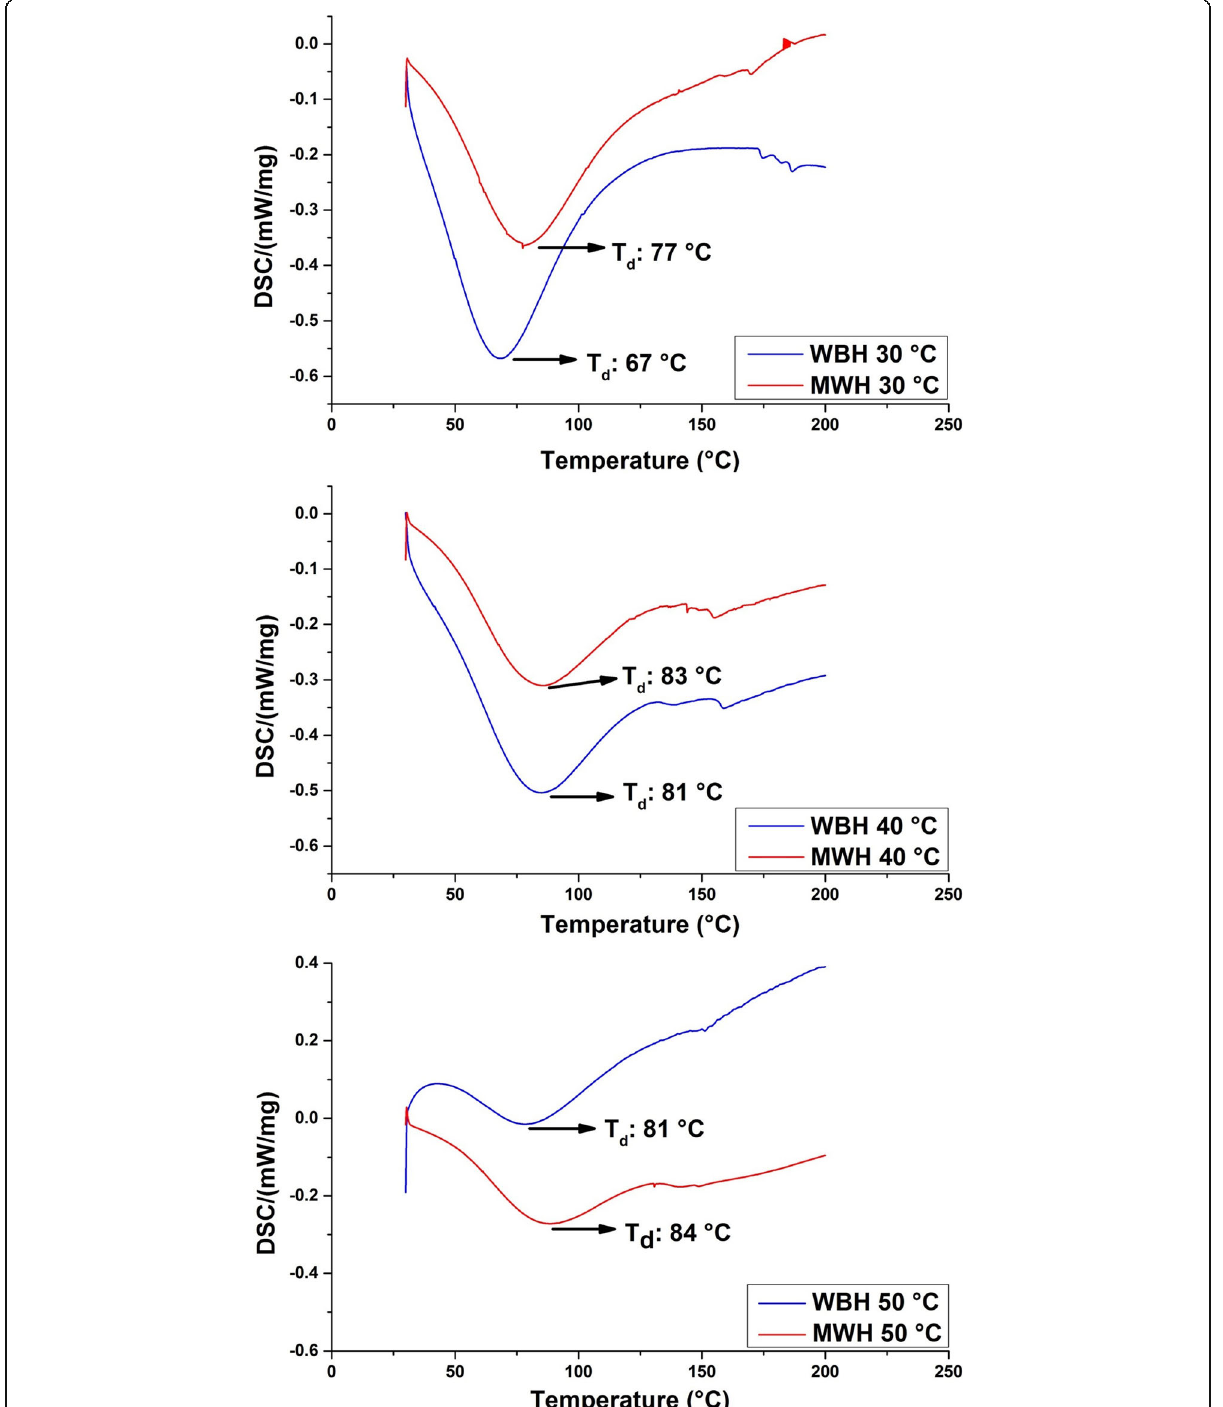
Fig. 2 DSC curves of hide powder tanned at 30 °C, 40 °C and 50 °C under different heating